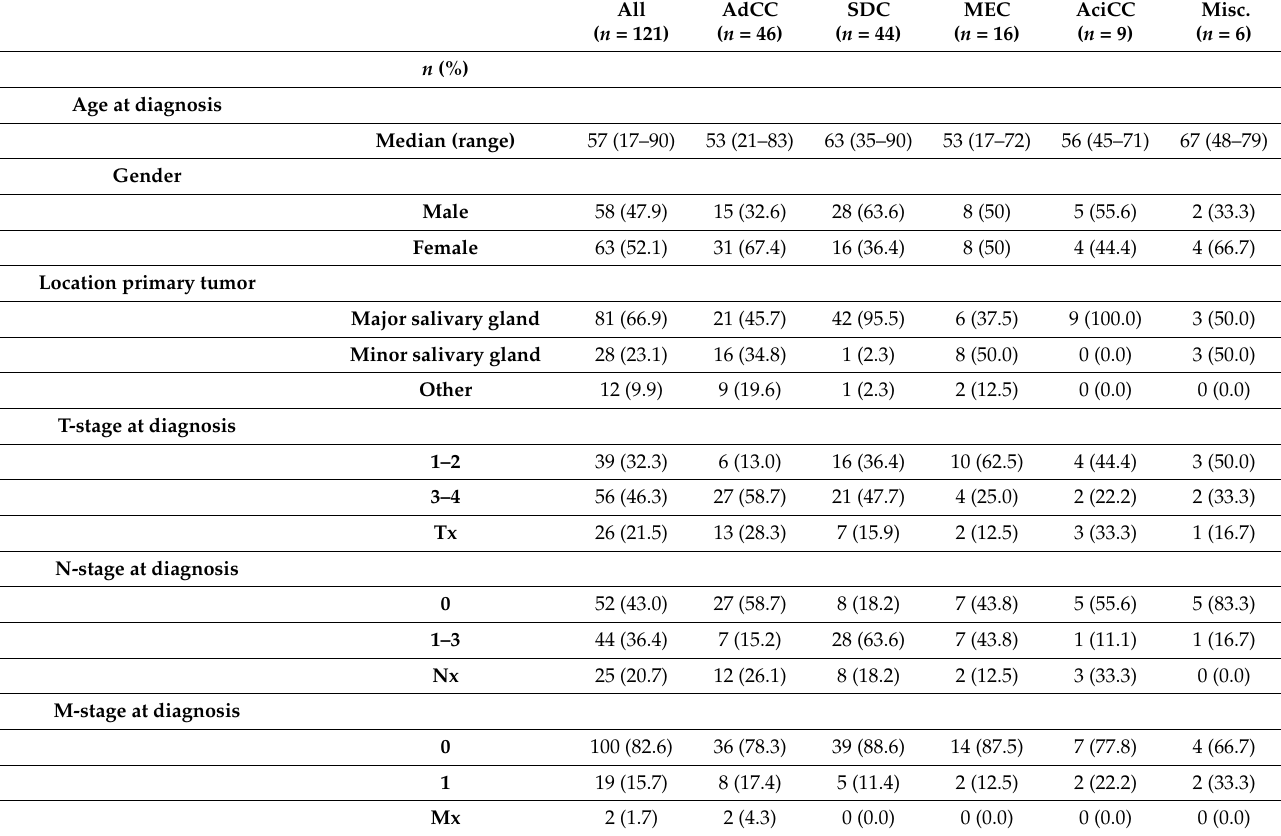
Table 1. Clinicopathological characteristics of the included patients. AdCC: adenoid cystic carcinoma, SDC: salivary duct carcinoma, MEC: mucoepidermoid carcinoma, AciCC: acinic cell carcinoma, misc.: miscellaneous; R/M: